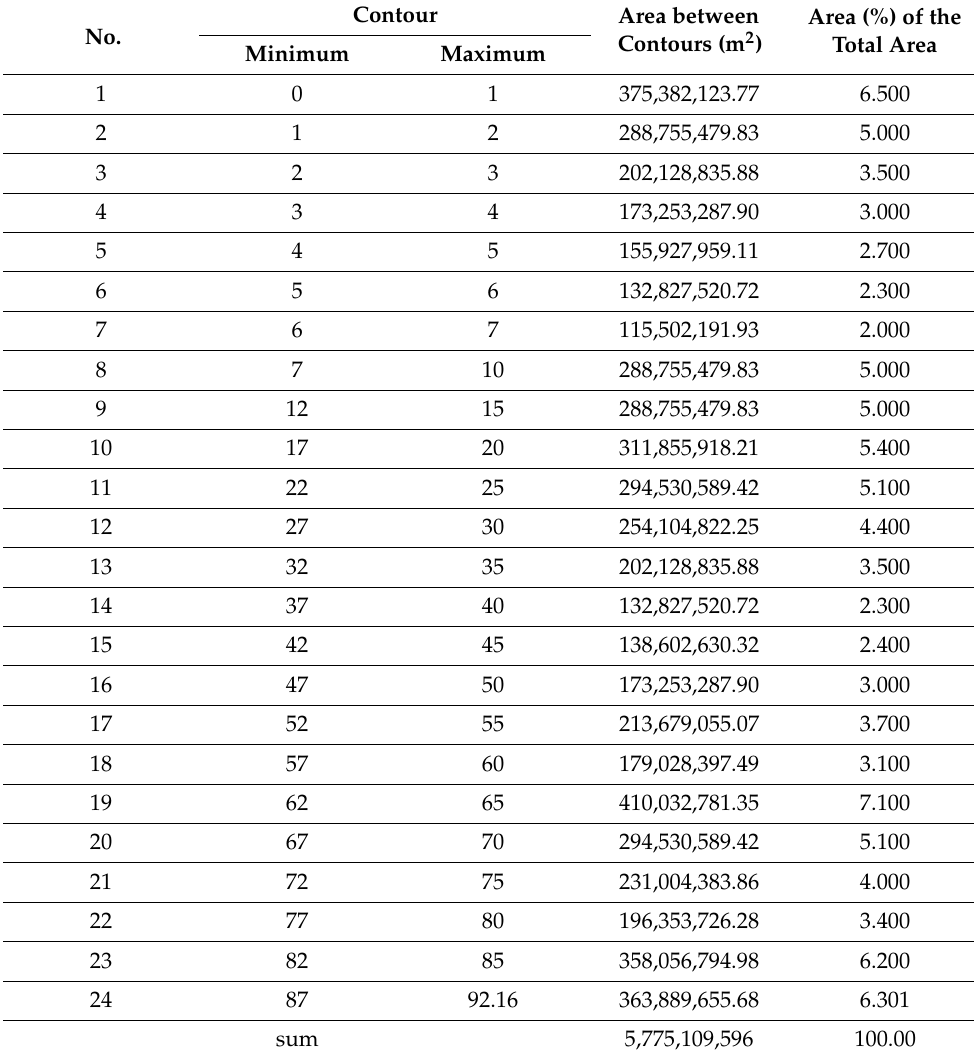
Table 6. The areas covered by different water